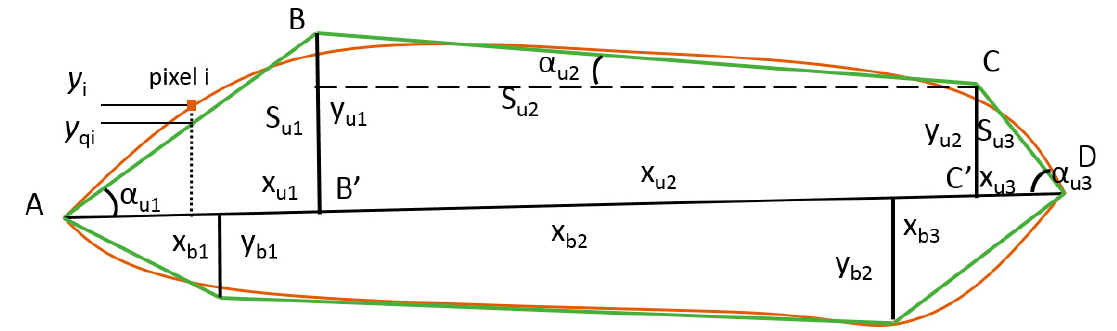
Figure 3. Representation of the spike shape as two quadrilaterals. Black horizontal line shows the spike axial line; brown line, spike contour; and green lines, quadrilaterals approximating spike contour. The main parameters characterizing geometry are shown for the upper quadrilateral. The dashed line is perpendicular to the axis through each pixel i of the contour; the height values for i th pixel, y i , an edge of quadrilateral, y qi , are shown.